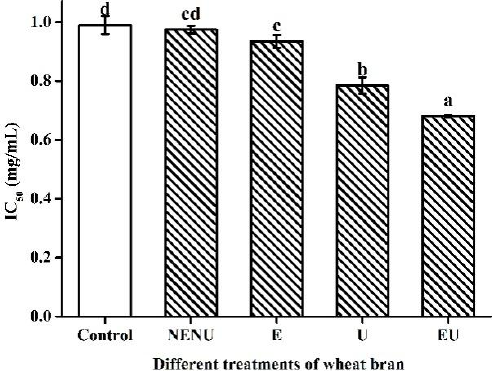
Figure 5. IC 50 values of phenolic extracts from Jizi439 BWB by different treatments. Control, white wheat bran (without extrusion and UAE); NENU, raw Jizi439 BWB (without extrusion and UAE); E, extruded but without UAE; U, UAE but without extruded; EU, extruded, and UAE; ( a – d ) Indicate a significant difference between different groups (n = 3; p < 0.05).